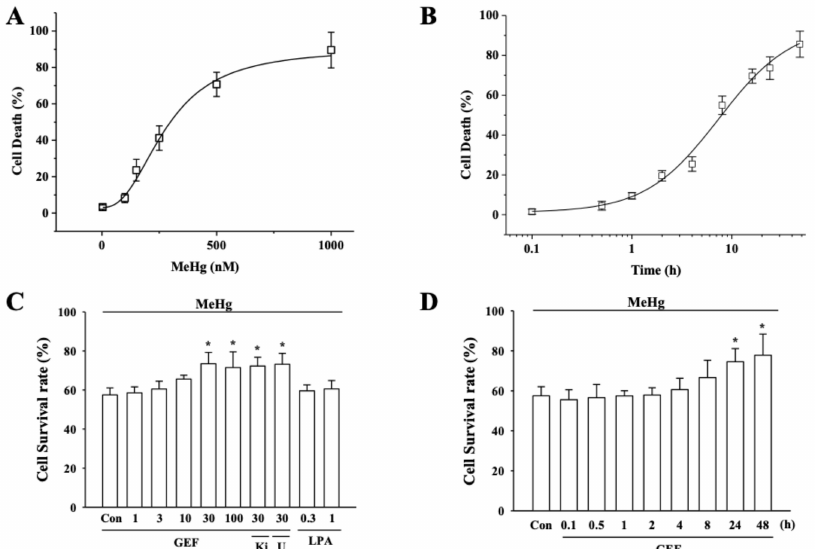
Figure 1. E ff ects of MeHg on cell death and e ff ects of gintonin-enriched fraction (GEF) with MeHg in hippocampal neural progenitor cell (hNPC) survival. ( A ) MeHg induces cell death in a concentration-dependent manner. The indicated concentration of MeHg was treated for 24 h. ( B ) MeHg-mediated cell death was time-dependent. hNPCs were treated with the indicated time